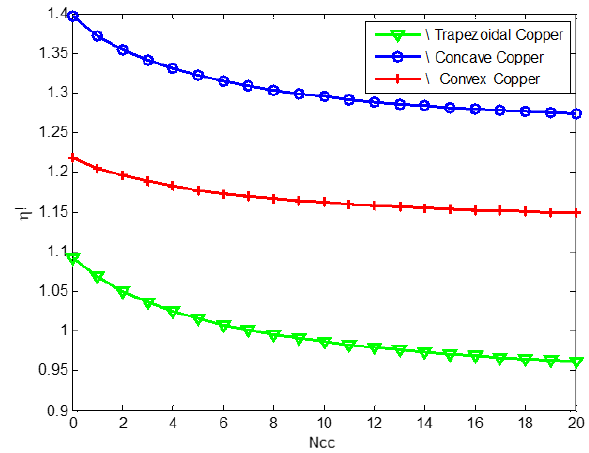
Figure 19. Variation in volume adjusted efficiency with peclect number for copper porous fins